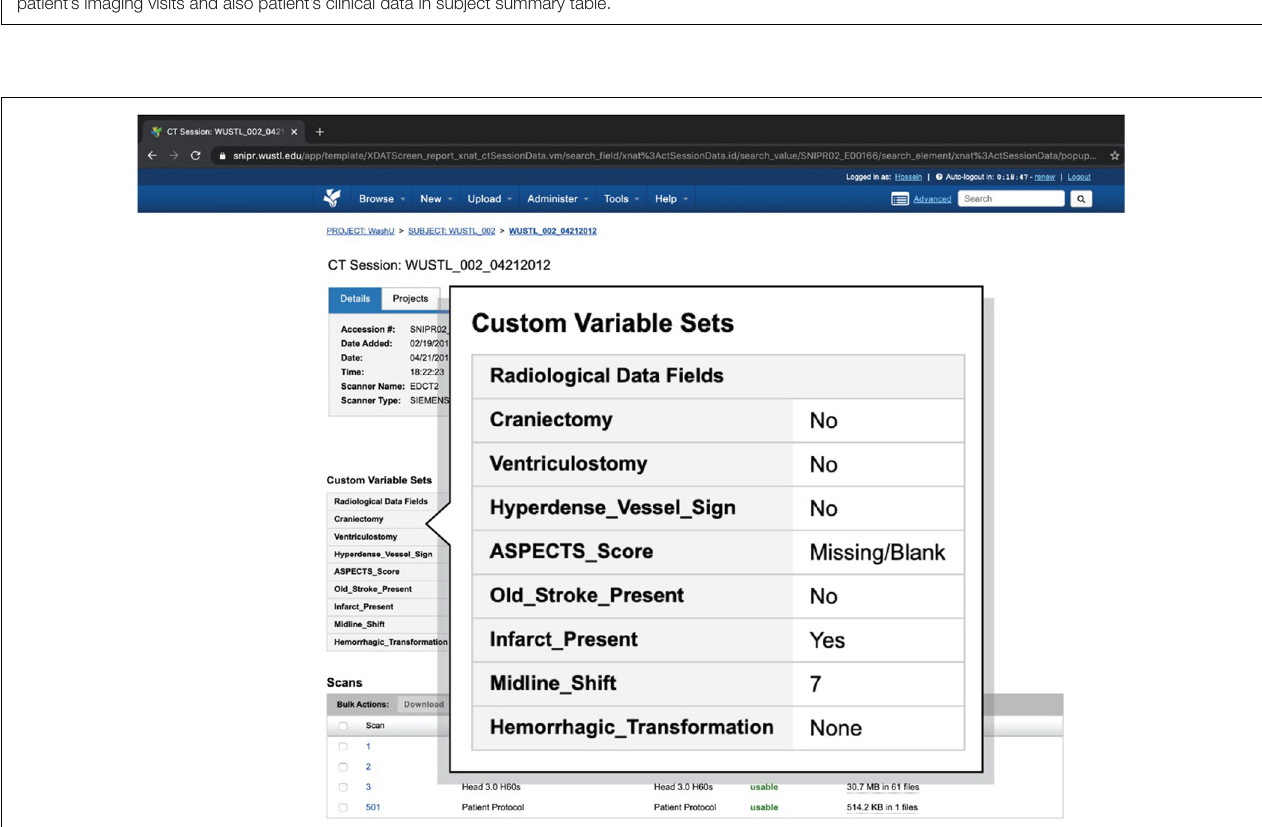
FIGURE 7 | SNIPR can manage clinical data and imaging CT scan studies for all imaging session studies of a patient. Each patient has several visits, each of which has a session page where users can have access to different imaging CT studies and also radiological information particular to that visit.